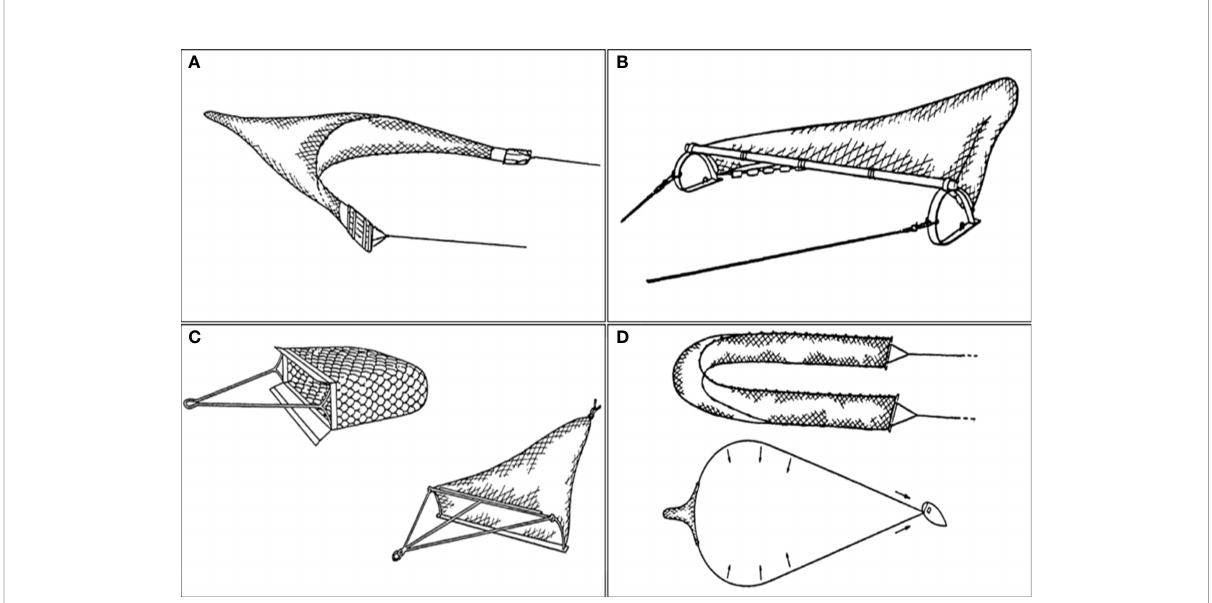
FIGURE 3 The four main bottom trawling gear types used within the UK EEZ. (A) Otter Trawl, (B) Beam Trawl, (C) Towed Dredge, and (D) Seine Trawl (Source: FAO, Technology Fact Sheets. https://www.fao.org/ fi shery/en/geartype/104/en).